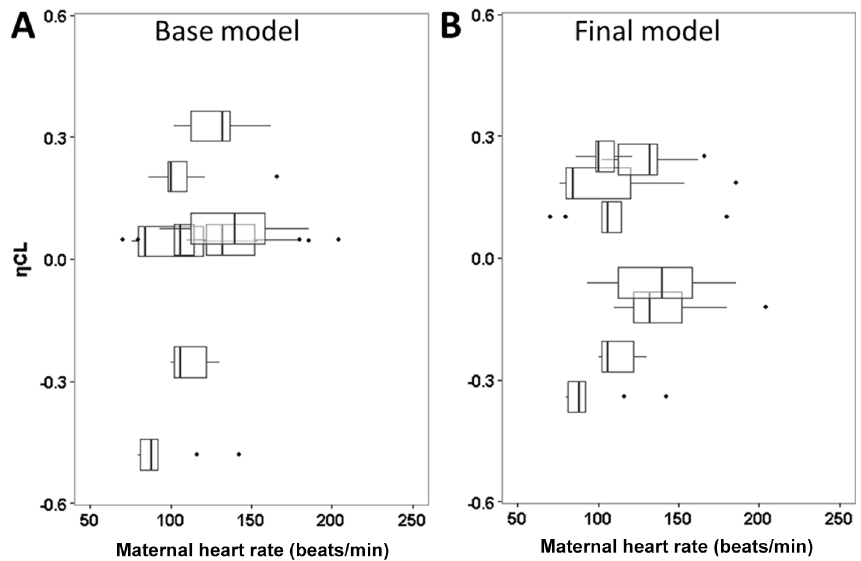
Fig 4. Between-subject random effects ( η ) for maternal clearance versus heart rate (HR) from the base (A) and final models (B). Each box represents data from one sheep. The lines in the box correspond to median values; the bottom and top of the box are the first and third quartiles (the 25th and 75th percentiles); the upper whiskers extend from the box to the highest value within 1.5 times of inter-quartile range (IQR); the lower whisker extend from the box to the lowest value within 1.5 times of IQR. The individual variability (Random effect, η ) for maternal clearance ( η CL) is narrower in the final model than in the base